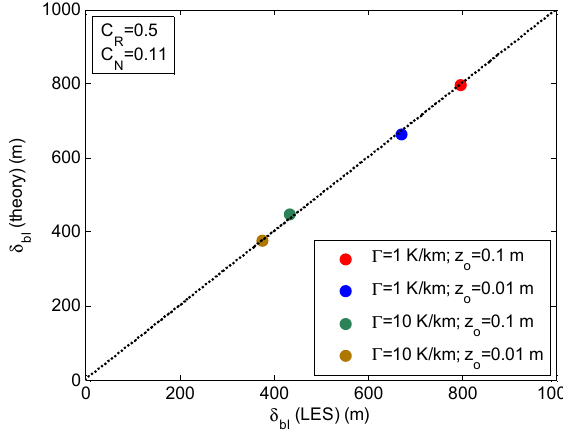
Figure 4. Correlation between the ABL heights: δ (theory) calculated from Equation (6) (cid:2912)(cid:2922) (with C = 0.5 and C = 0.11 ) and δ (LES) directly obtained from LES. (cid:2902) (cid:2898) (cid:2912)(cid:2922)